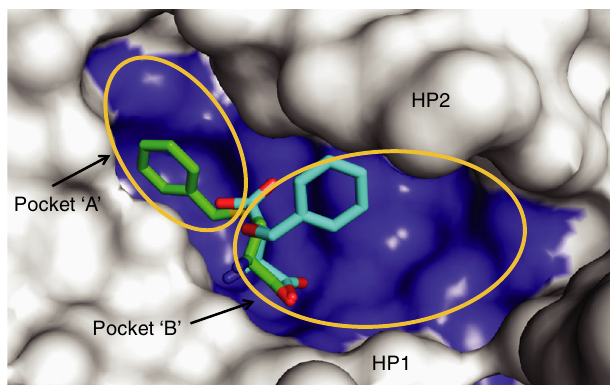
Fig. 7 Binding pocket of Glt Ph -R397C Surface representation of the binding